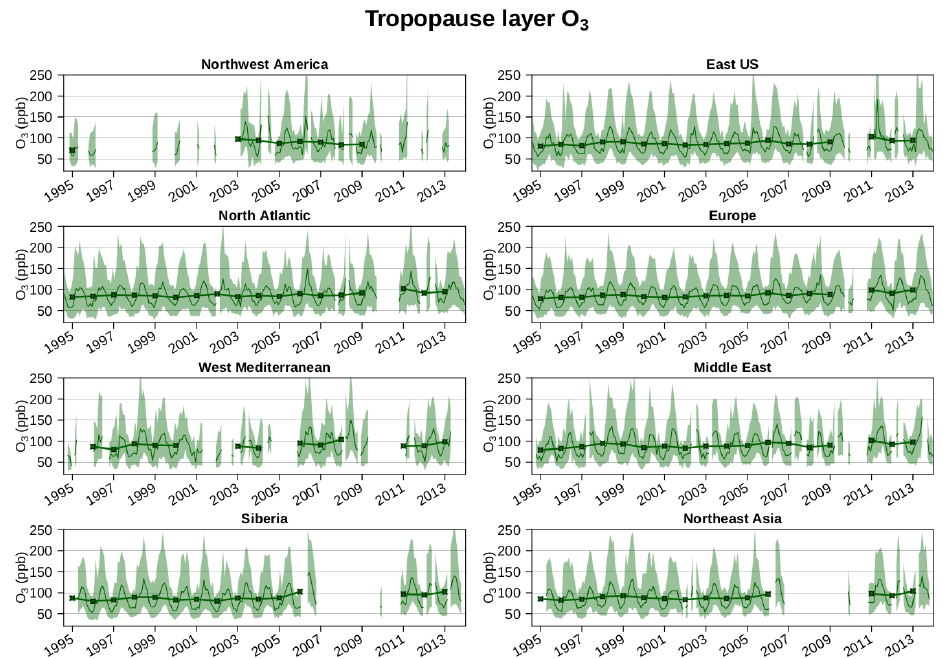
Figure B2. O 3 monthly mean values in the TPL (thin curve). The interval from 5th and 95th percentiles is filled in green. The yearly mean values are represented by the bold curve and the black